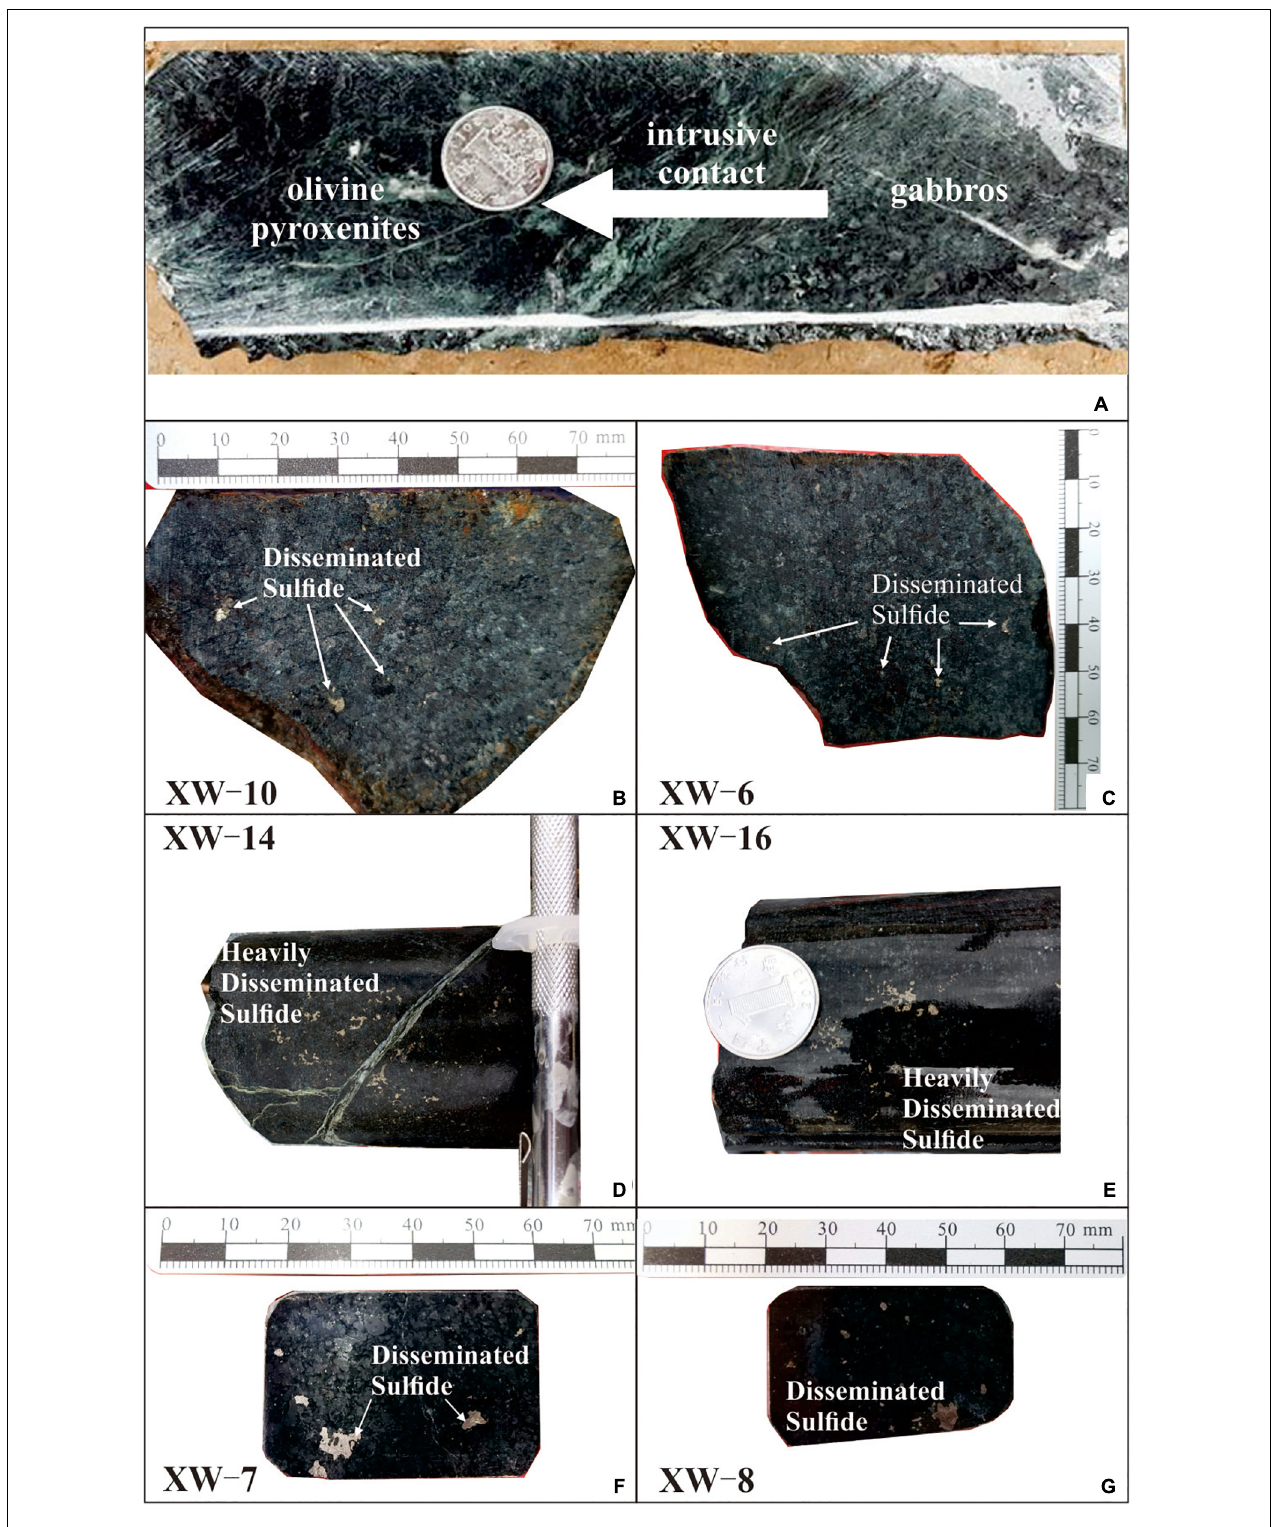
FIGURE 2 | Hand specimen photos of the Xiwanggou mafic-ultramafic rocks. (A) The intrusive contact relationship between olivine pyroxenite and gabbro; (B,C) Disseminated Cu–Ni sulfide minerals developed in gabbro and olivine gabbro, respectively; (D–G) Disseminated Cu–Ni sulfide minerals in olivine pyroxenite.